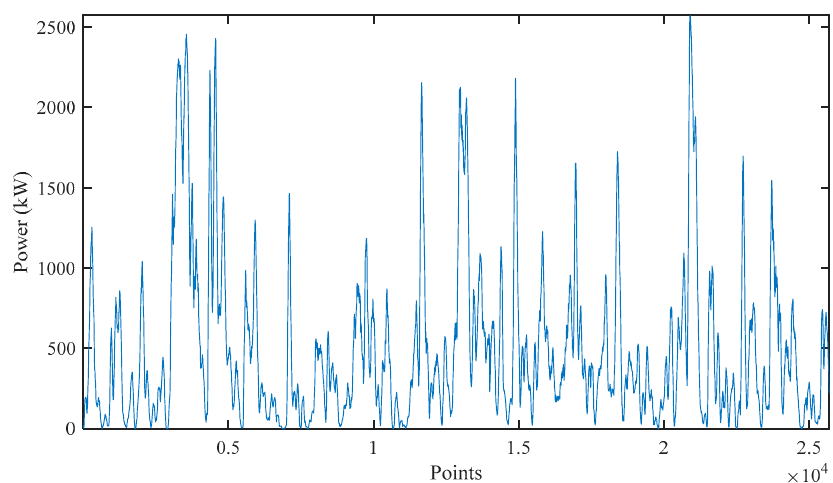
Figure 7. Actual power generation of the wind turbine (Case 1).